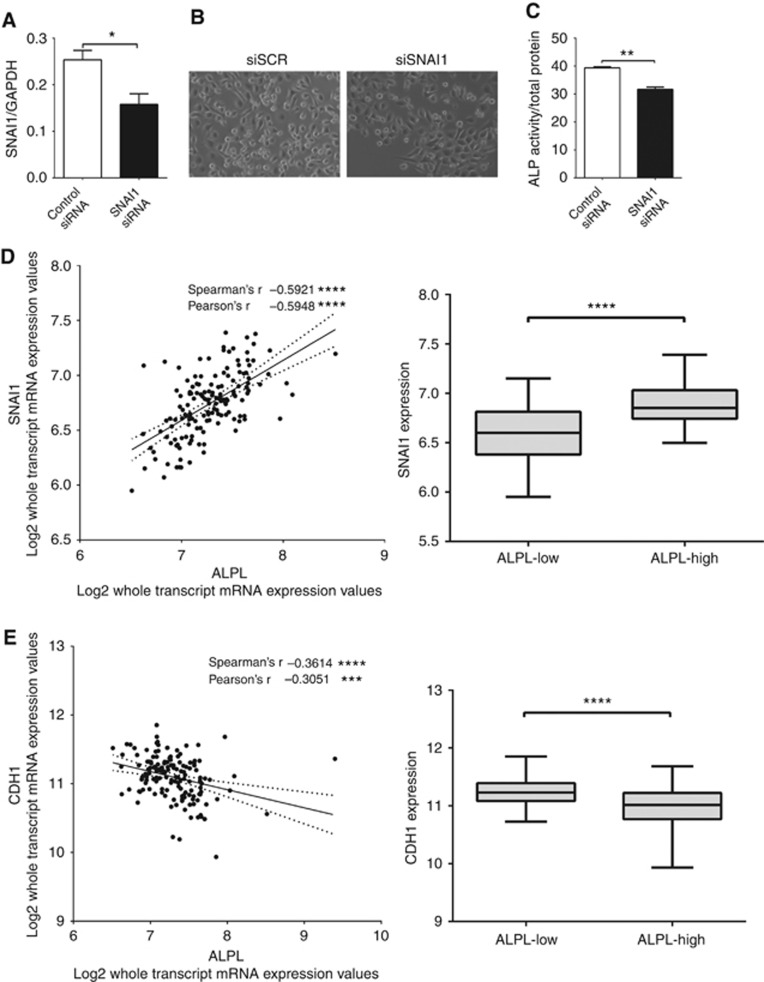
Snail regulates expression of alkaline phosphatase in vitro and in vivo.
In vitro, Snail expression was inhibited by transfecting siRNA in ARCaPM cells and (A) knockdown was confirmed using qRT–PCR. (B) Change in morphology after Snail knockdown was documented using phase-contrast microscopy. (C) Alkaline phosphatase activity was measured in siRNA-transfected ARCaPM cells using a quantitative fluorimetric assay. The correlation of (D) Snail mRNA or (E) CDH1 (E-cadherin) mRNA with ALPL mRNA expression was calculated in prostate cancer samples from the Taylor et al. data set (Taylor et al, 2010). In each case, the samples were also stratified into ALPL-high or ALPL-low samples (with median ALPL expression as the cutoff) and Snail or E-cadherin expression were plotted, respectively (NSP>0.05, *P<0.05, **P<0.01, ***P<0.001, ****P<0.0001).